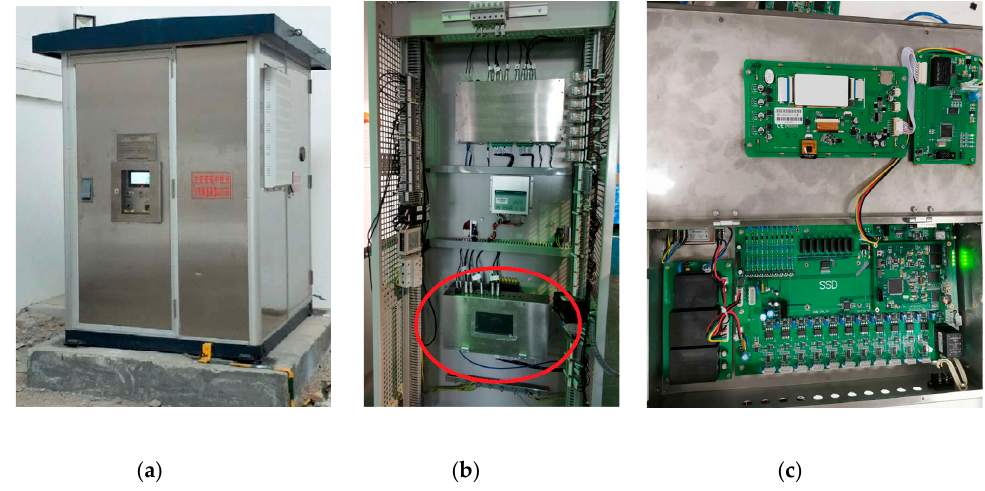
Figure 2. The hardware of the DC bias monitoring device of the transformers: ( a ) device appearance; ( b ) synchronous monitoring device; ( c ) physical picture of internal hardware.